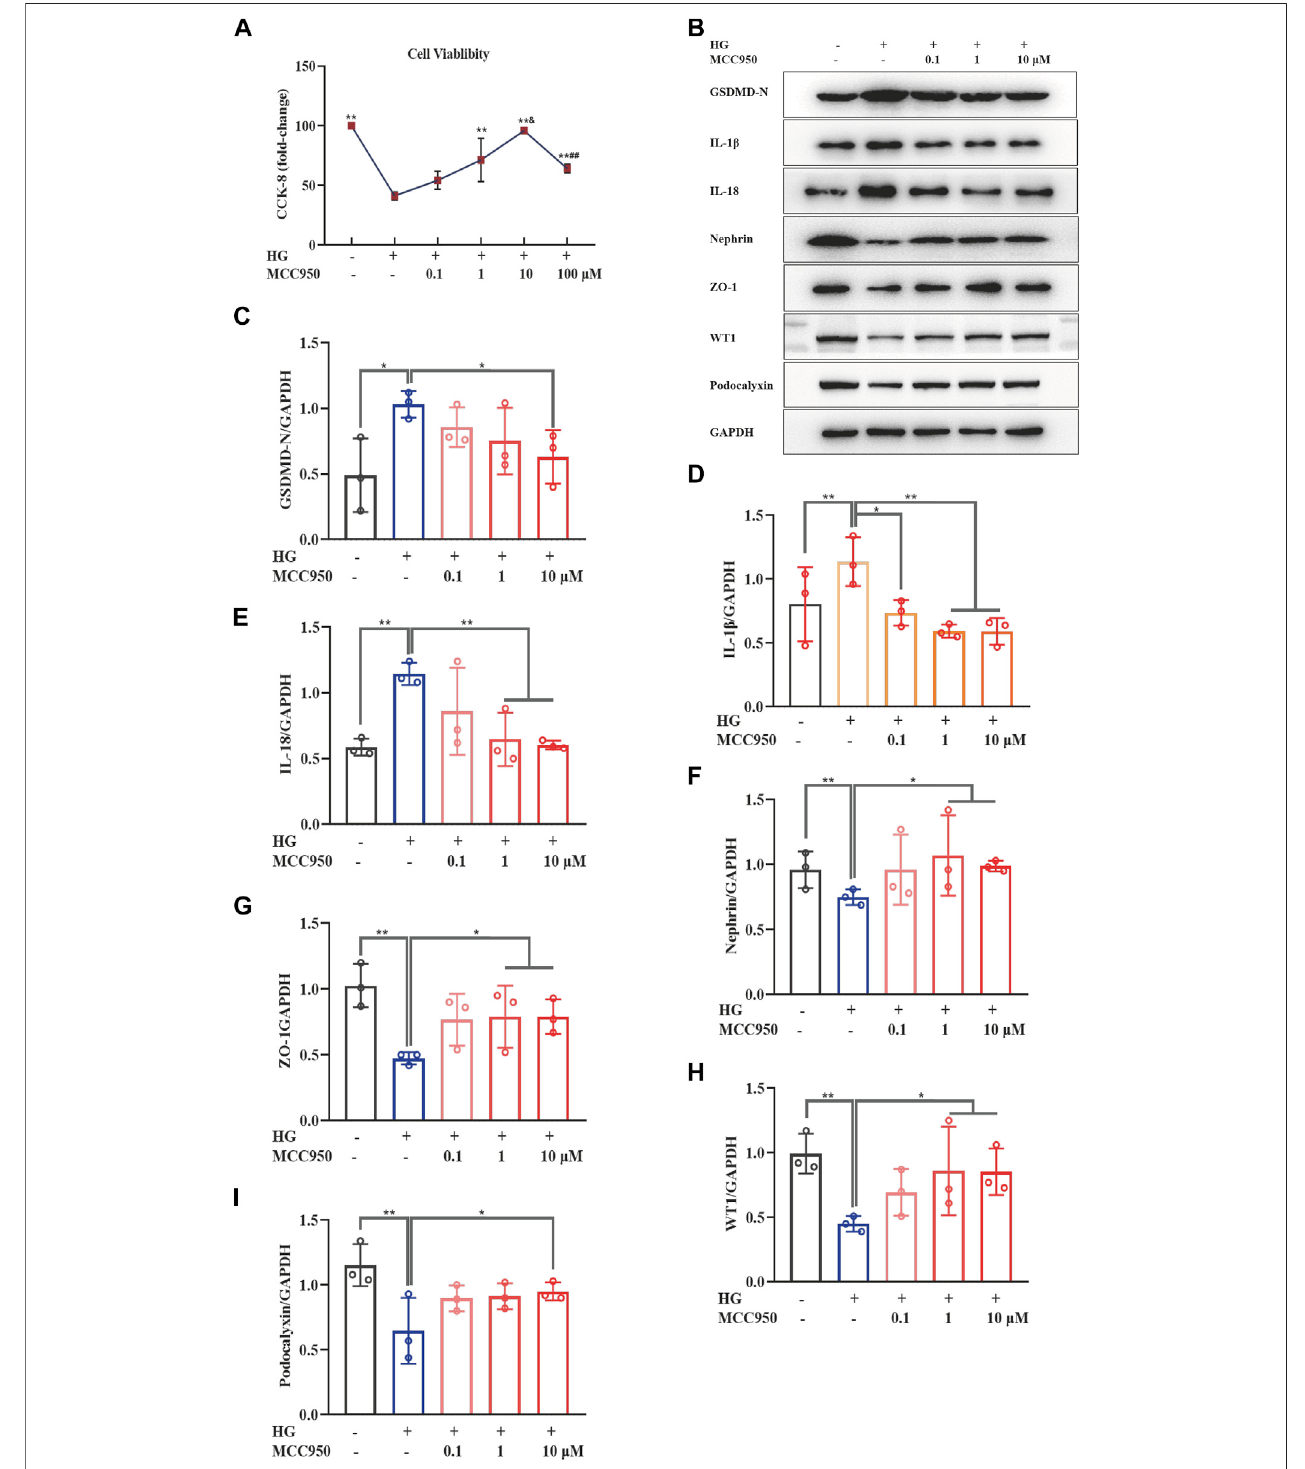
FIGURE 2 | MCC950ameliorated podocytepyroptosisand injuryinduced byHGina dose-dependent mannerinMPC-5 cells. (A) The cellviability incultured MPC-5 cells exposed to HG at 30 mM for 48 h with or without MCC950 at 0.1, 1, 10, and 100 μ M for 24 h; (B) WB analysis of GSDMD-N, IL-1 β , IL-18, nephrin, ZO-1, WT1 and podocalyxininculturedMPC-5cellsexposedtoHGat30 mMfor48 hwithorwithoutMCC950at0.1,1,and10 μ Mfor24 h; (C) GSDMD-Nwasquanti fi edbydensitometry; (D) IL-1 β was quanti fi ed by densitometry; (E) IL-18 was quanti fi ed by densitometry; (F) Nephrin was quanti fi ed by densitometry; (G) ZO-1 was quanti fi ed by densitometry; (H) WT1wasquanti fi edbydensitometry; (I) Podocalyxinwasquanti fi edbydensitometry.Dataareexpressedasmean ± S.D.,( n (cid:2) 3).* p < 0.05,** p < 0.01 vs. the HG group; & p < 0.05 vs. the TFA (10 μ g/ml) group; ## p < 0.01 vs. the TFA (20 μ g/ml) group. Abbreviations: HG, high glucose; MPC-5, mouse podocyte cell-5; WB, western blotting; GSDMD-N, N-terminus of GSDMD; IL-1 β , interleukin-1 β ; IL-18, interleukin-18; ZO-1, Zonula occludens 1; WT1, Wilms tumor type 1.